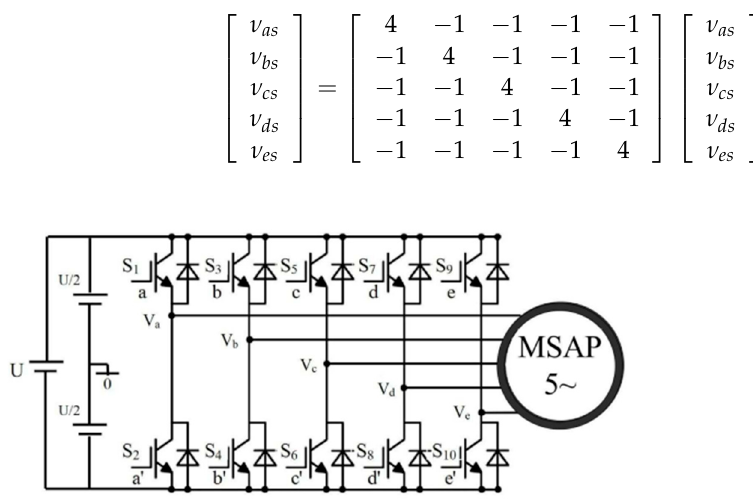
Figure 1. Five-phase Voltage Source Inverter (VSI)